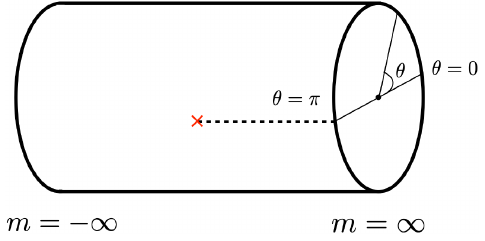
FIG. 4. A schematic of the phase diagram of the one- dimensional U ( 1 ) LGT in term of the mass parameter m and the topological angle θ around π . The dashed line represents the deconfinement